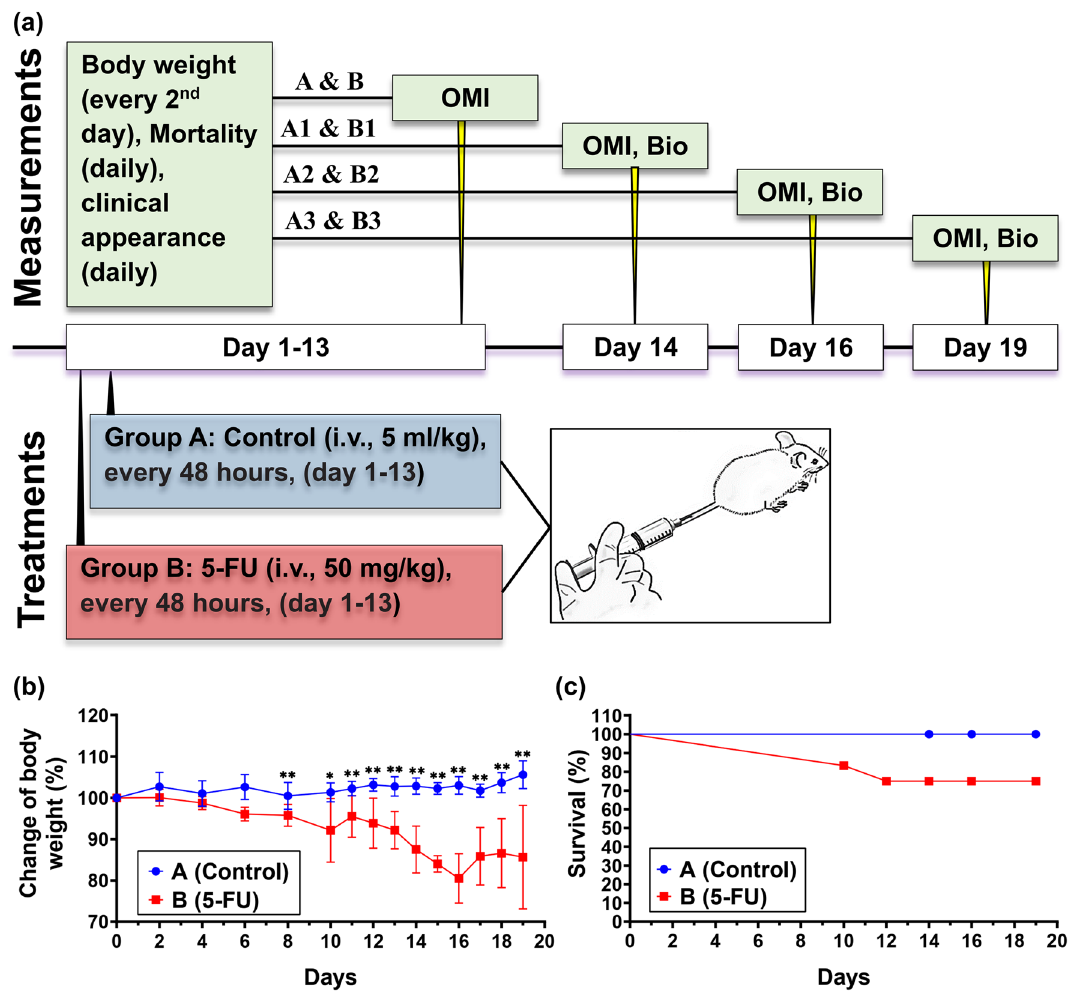
Figure 1. 5-FU reduces body weight and survival of mice. ( a ) Schematic of the experimental procedure. 6–12 weeks-old C57BL/6 female mice were divided into 2 groups: Group A; Saline as normal control; Group B; 5-FU as positive control. 5-FU (50 mg/kg/day) was injected intravenously at 2-day intervals, starting from day 1 to day 13. Group A received physiological saline (the vehicle of 5-FU, 5 ml/kg/day). At days 14, 16, and 19 mice were sacrificed, and the tongue and the jejunum, were retrieved at necropsy. ( b ) Changes in body weight (BW) over time during 5-FU administration; BW of mice was measured every 24–48 h. The BW percentage change of each mouse was calculated and compared with the percent of BW at day 0. The mean BW of every group at day-0 was defined as 100%. Data are represented as mean ± standard error of mean (SEM). Multiple t tests were used to determine the statistical significance between the two groups. ( c ) Time-course of survival during 5-FU treatment. Logrank test was used for comparative analysis of survival rates. * P < 0.01 versus 5-FU group; ** P < 0.001 versus 5-FU group; ( n = 9 and 12 for group A and B,